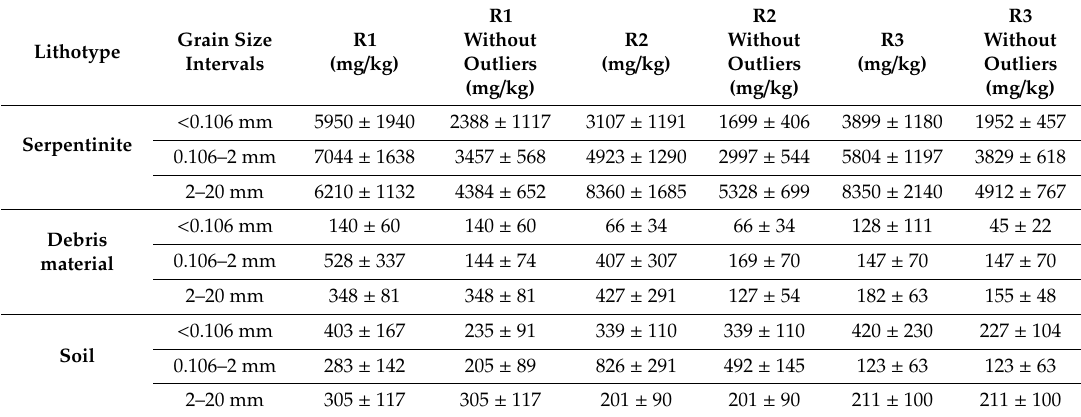
Table 3. Concentrations and intrinsic errors related to the method (for the three grain size fractions)